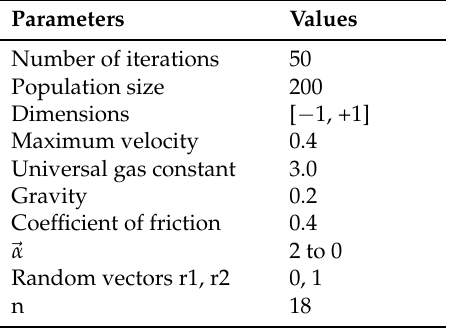
Table 9. Parameters of GWDO.